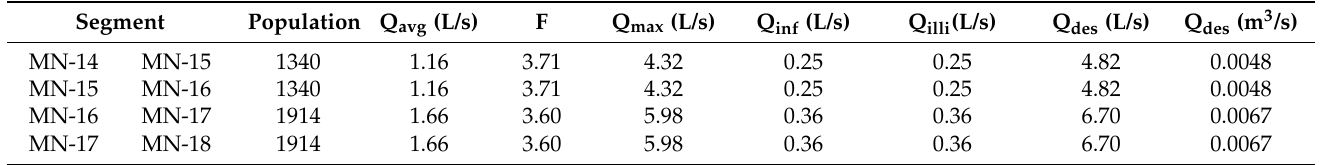
Table 11. Design flow rates for expansion zones 2 and